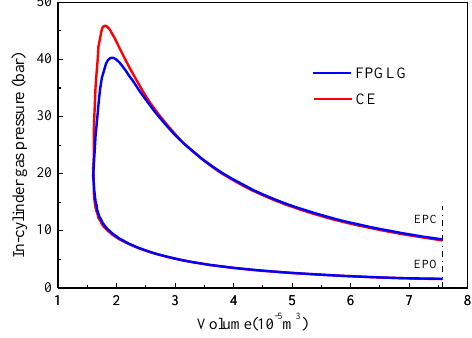
Figure 14. Pressure-volume diagram.